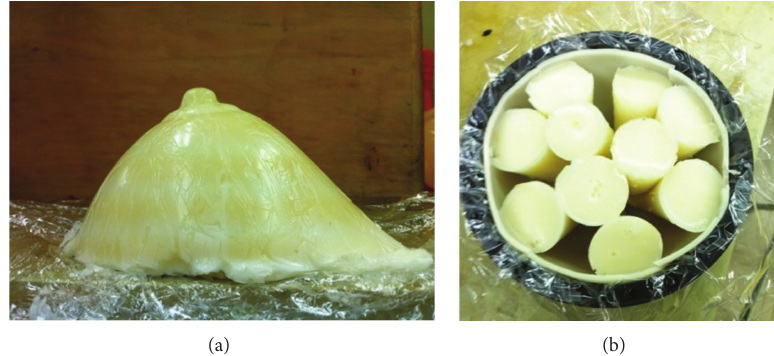
Figure 14: Two photographs of the heterogeneous breast phantoms: (a) exterior view of the realistically shaped breast phantom and (b) coronal view of the 2mm skin layer and the conical gland structures embedded inside the phantom.